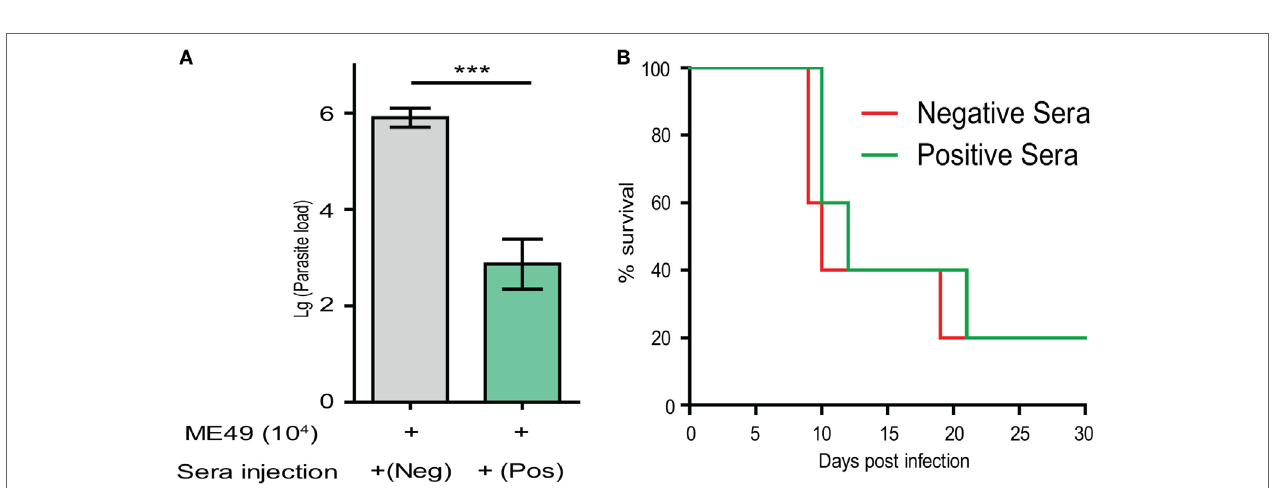
FigUre 7 | Passive immunization using the sera from Δ ldh -vaccinated mice provided partial protection against parasite infection. (a) ICR mice ( n = 3 for each group) were injected with 10 4 tachyzoites of ME49 by intraperitoneal injection. At day 0 and day 3 post-infection, mice were treated with positive sera collected from the ME49 Δ ldh -vaccinated mice (160 days post-vaccination), or negative serum from naïve mice by tail intravenous injection. Parasite loads in peritoneal fluids 7 days post-infection were estimated by quantitative PCR. *** p < 0.0001, Student’s t -test. (B) Survival of passively immunized mice.